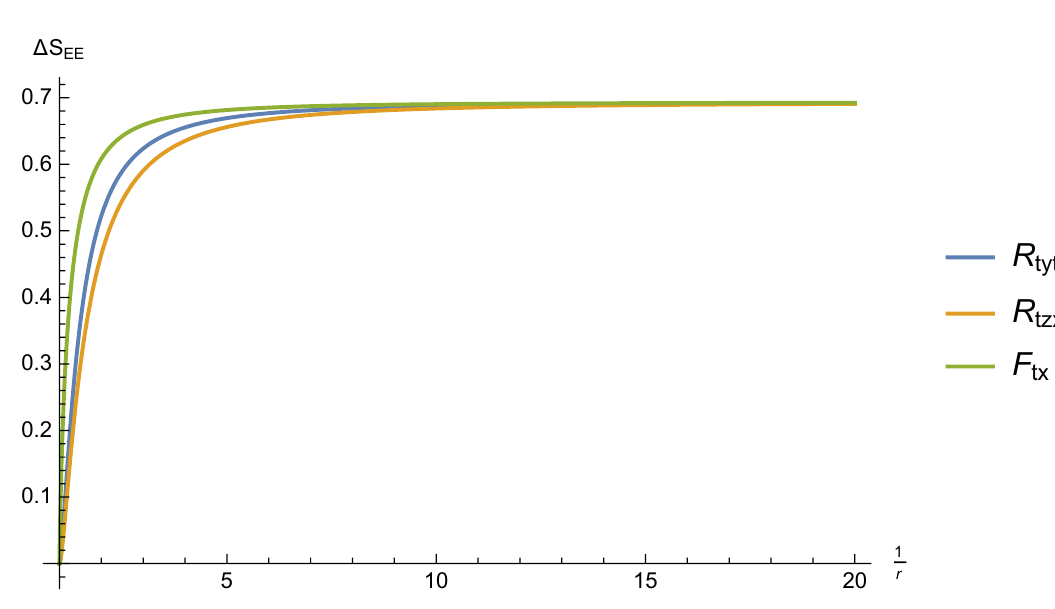
Figure 7 . ∆ S EE as a function of 1 /r = t/y 0 in the zero width limit for vectors under SO(2) T × SO(2) L . Class 2, 3 are represented by R tytx , R tzxz respectively. The growth due to the quench due to the vectors from the U(1) field is higher than those due to the spin-2 fields.